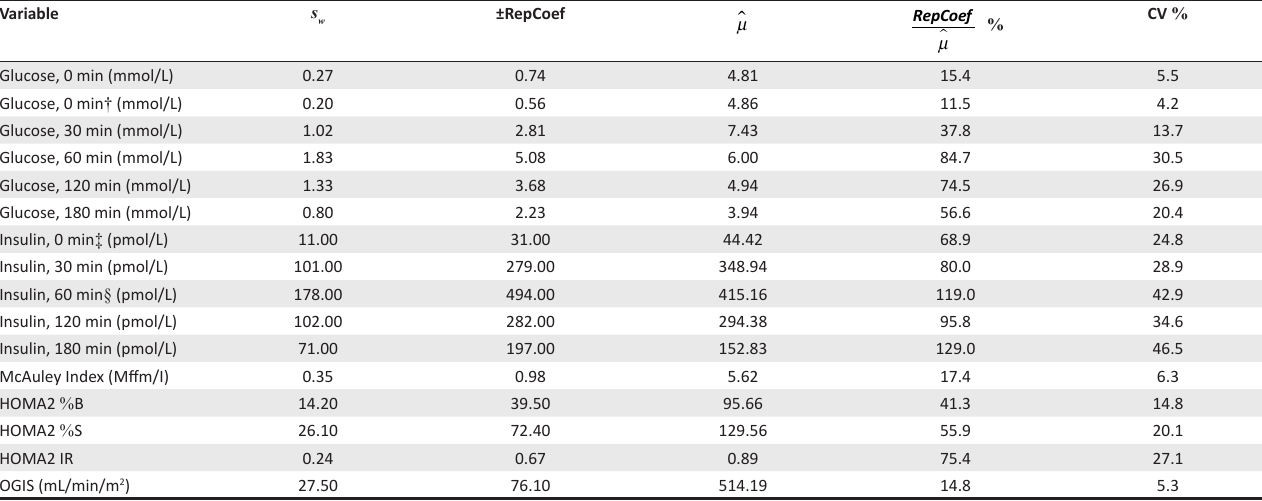
TABLE 2: Repeatability coefficients for all participants. Variable